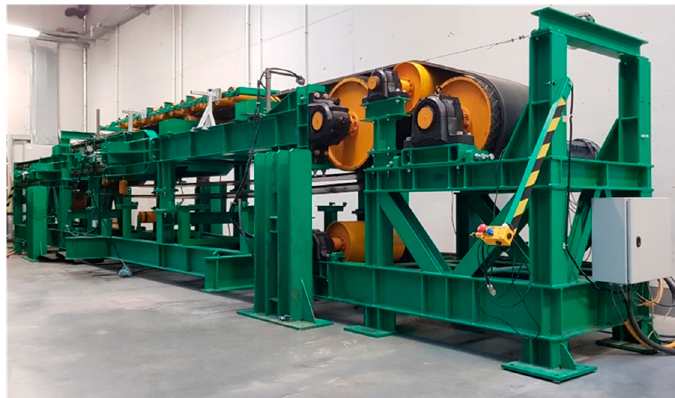
Figure 1. Intermediate belt drive test rig.